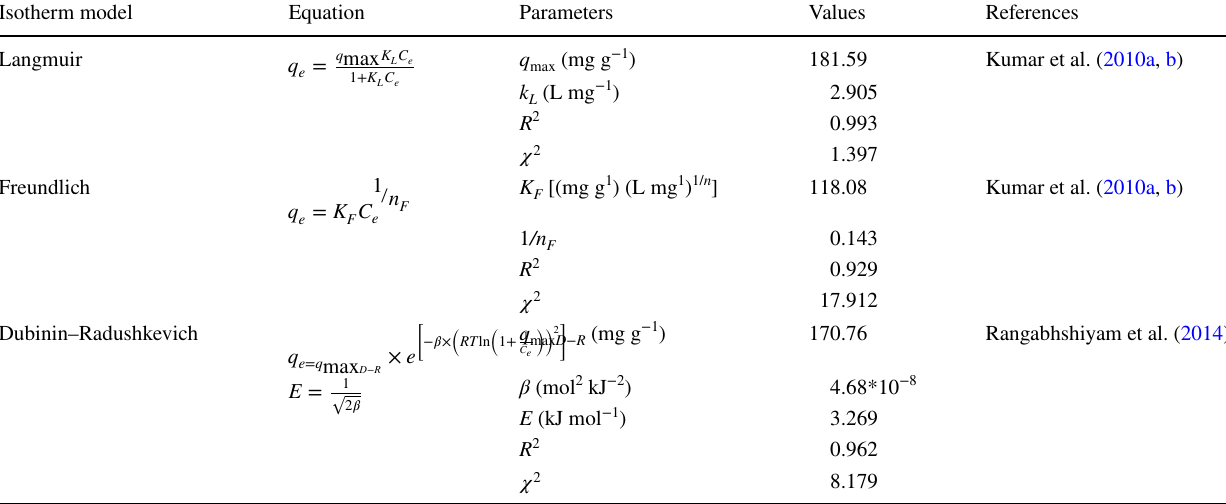
Table 6 Summary of constants parameters for isotherm models and correlation coefficients estimated for the adsorption of AB25 onto WDS-AC Isotherm model